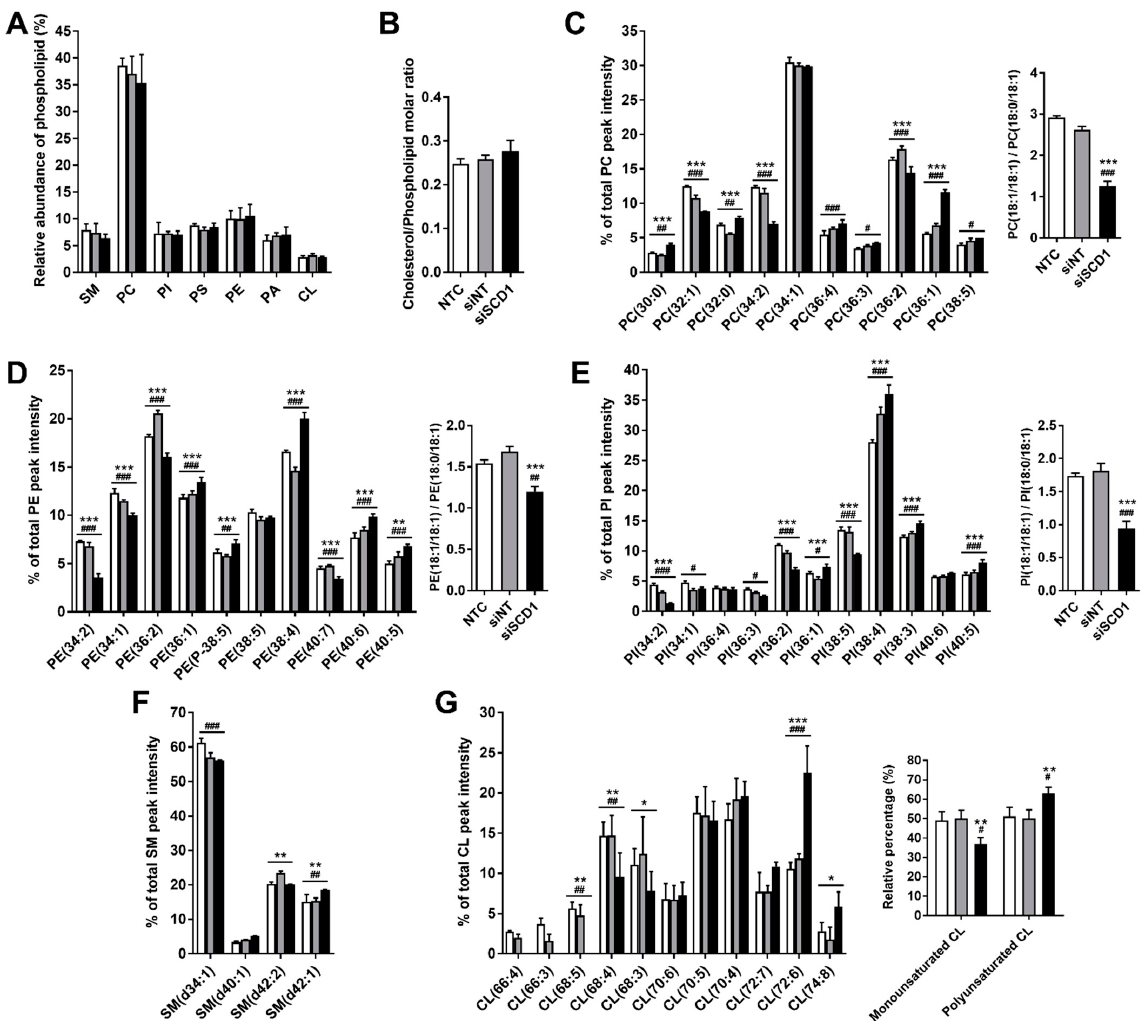
Figure 4. Effect of SCD1 silencing on phospholipid (PL) and cholesterol content and relative abun- dance of individual PL molecular species in U87 cells. Cells grown in a medium containing 2% FBS were either non-treated (NTC, white bars) or transfected with an siRNA against SCD1 (siSCD1, black bars) or a non-targeting siRNA sequence (siNT, grey bars) complexed with Lipofectamine RNAiMAX. Sixty-eight hours after transfection, lipids were extracted, and PLs analyzed by thin- layer chromatography (TLC; ( A )) and HPLC-MS ( C – G ), and the cholesterol content quantified using Amplex Red Cholesterol Assay Kit ( B ). ( A ) The relative abundance of each PL class, recovered from the corresponding spot in the thin-layer chromatogram and evaluated in moles of phosphorus, is expressed as a percentage of total phospholipid in the lipid extract, estimated as the sum of phos- phorus contents (in moles) presented in all of the spots of the chromatogram ( n = 3). ( B ) The choles- terol-to-phospholipid ratios are expressed as nmol of total cholesterol per nmol of phospholipid phosphorus. ( C – G ) Relative abundance of the molecular species within each PL class-PC ( C ), PE ( D ), PI ( E ), SM ( F ) and CL ( G )—analyzed by HPLC-MS in positive mode ( C , F ) and negative mode ( D , E , G ), is expressed as a percentage obtained from the ratio between the reconstructed area of each molecular species and the sum of all of the reconstructed areas considered for each class, multiplied by 100 (n = 2–3, two-way ANOVA followed by Tukey’s test; # p < 0.05, ## p < 0.01, ### p < 0.001 siSCD1 vs. NTC; * p < 0.05, ** p < 0.01, *** p < 0.001 siSCD1 vs. siNT). Species are annotated as PL(C:N), where PL is the phospholipid class, C the number of carbons, and N the number of double bonds. The ratio of the molecular species 36:2 (18:1/18:1)-to-36:1 (18:0/18:1) for the phospholipid classes PC ( C ), PE ( D ) and PI ( E ) were calculated from individual